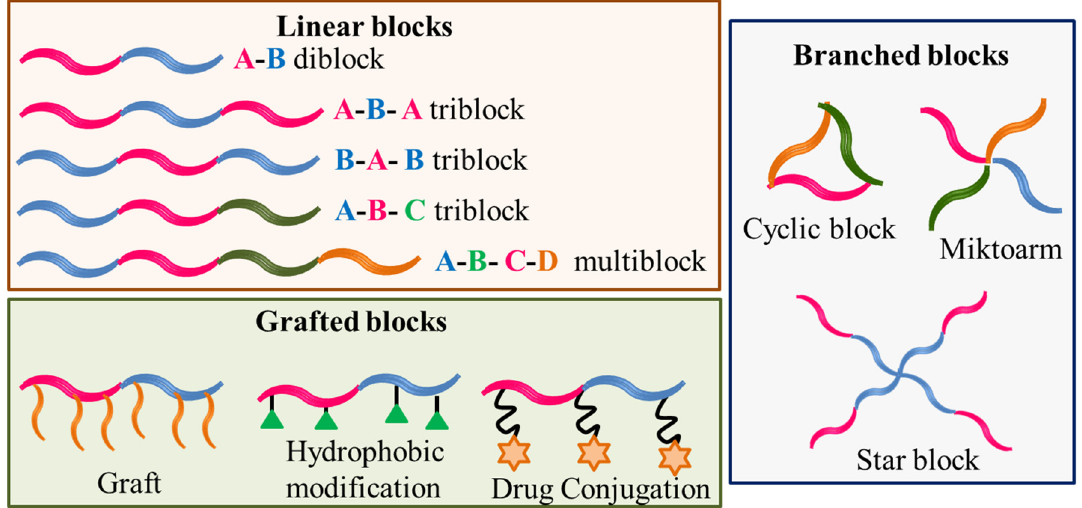
Figure 1. Schematic designer representations of some block copolymer structures.